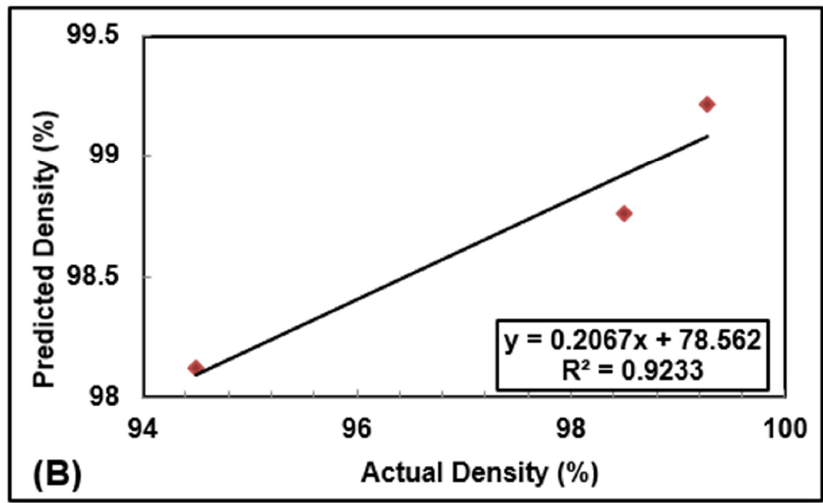
Figure 10. SVM model: ( A ) comparison of the actual and predicted density of AM SS316L and ( B ) statistical correlation between actual and predicted values for the applied model.